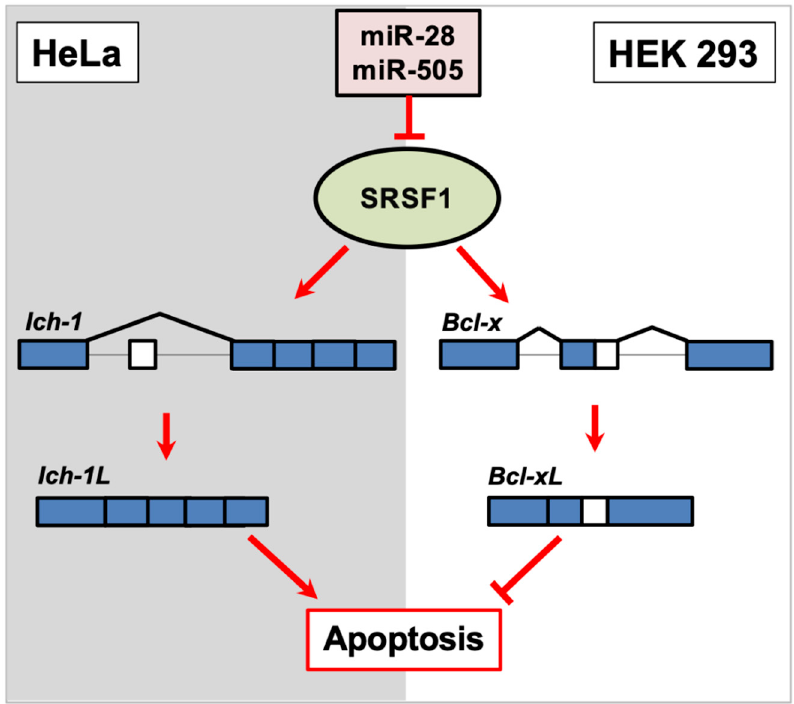
Figure 2. In HeLa cells, SRSF1 promotes exon skipping in Ich-1 to produce the pro-apoptotic Ich-1L isoform. However, in HEK 293 cells, SRSF1 promotes the expression of Bcl-xL , the anti-apoptotic isoform of Bcl-x , by favoring a distal 5 ′ splice site. miR-28 and miR-505 directly target the 3 ′ UTR of SRSF1 , and the result induces a shift of the isoform ratios of Ich-1 and Bcl-x .